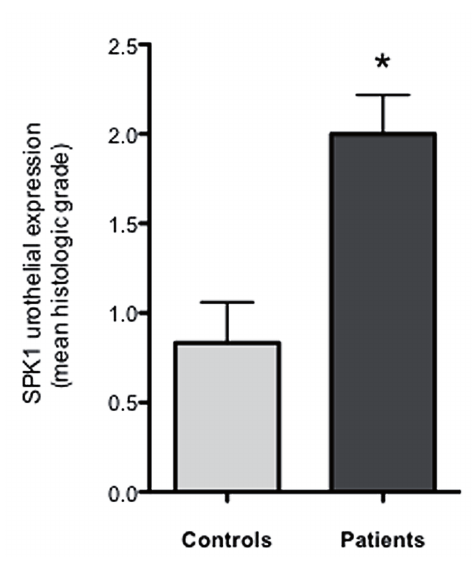
figure 2 - spK1 urothelial expression.